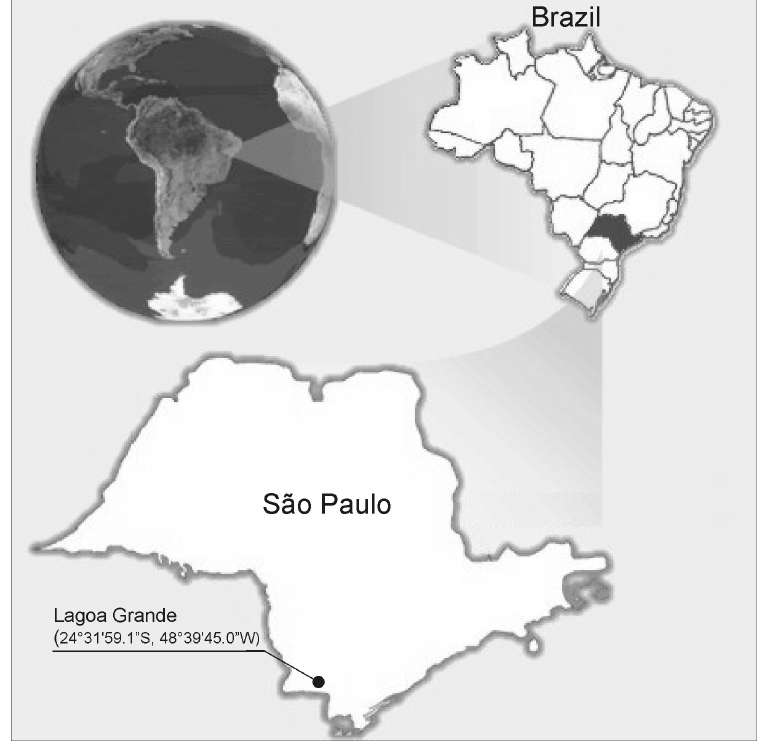
Fig. 1 – Location of the study